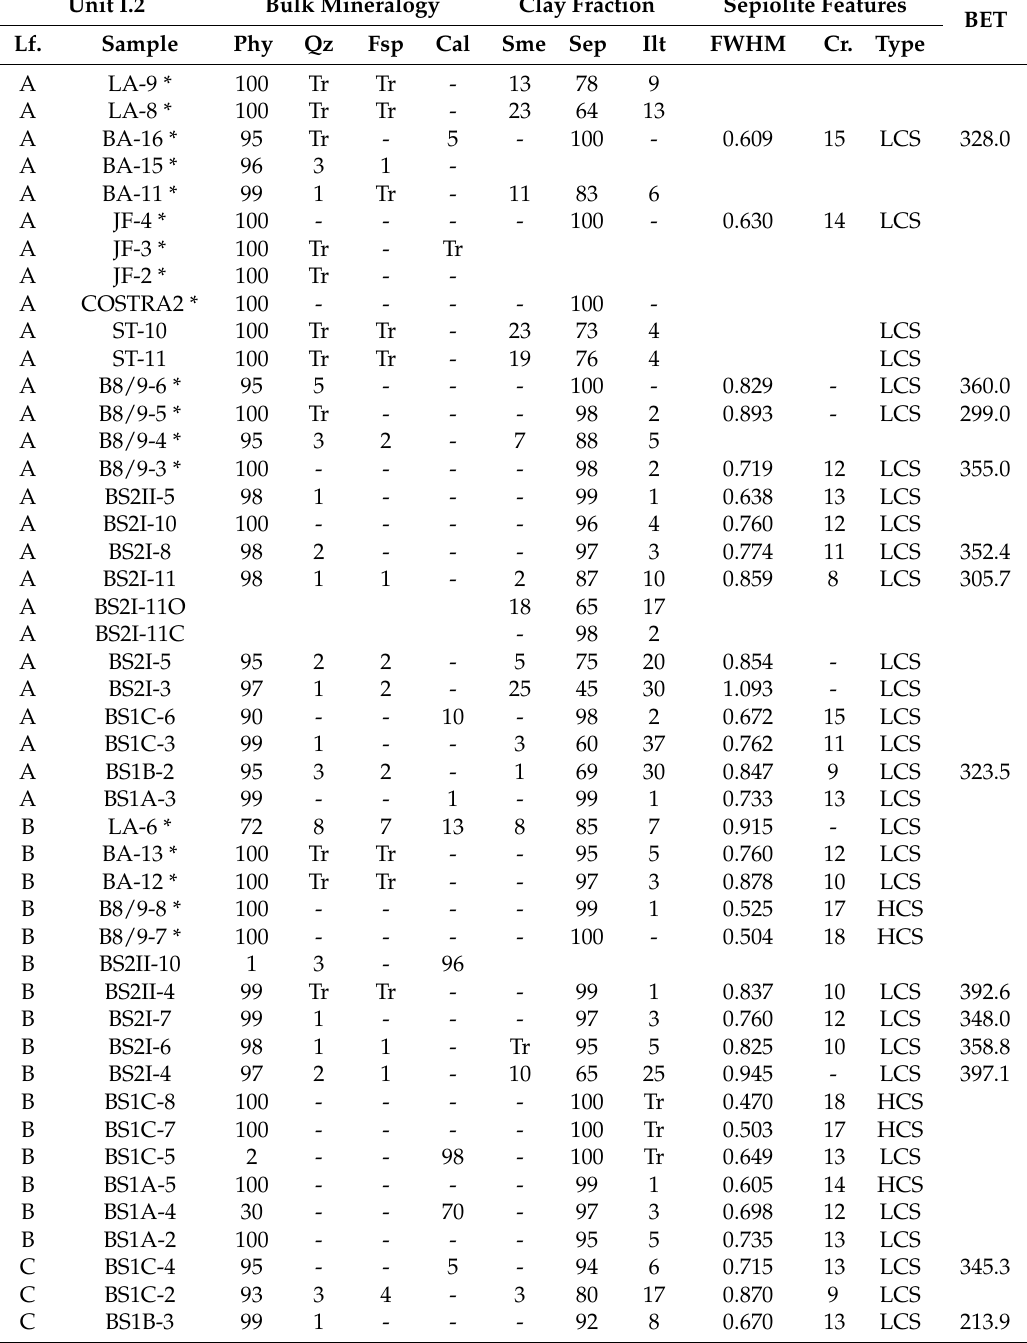
Table 2. Bulk (% w / w ) and clay mineralogy (% w / w ) of Unit I.2 lithofacies. Sepiolite FWHM values ( ◦ 2 Θ ), crystallite sizes (Cr.) (nm) and “crystallinity” are also shown. Abbreviations are according to Whitney and Evans [27], except phyllosilicates (Phy), trace minerals (Tr) and not detected (-): Qz, quartz; Fsp, feldspar; Cal, calcite; Dol, dolomite; Sme, smectite; Sep, sepiolite; Ilt, illite; Kln, kaolinite. The order inside each lithofacies group of samples is related with the geographical location, from north to